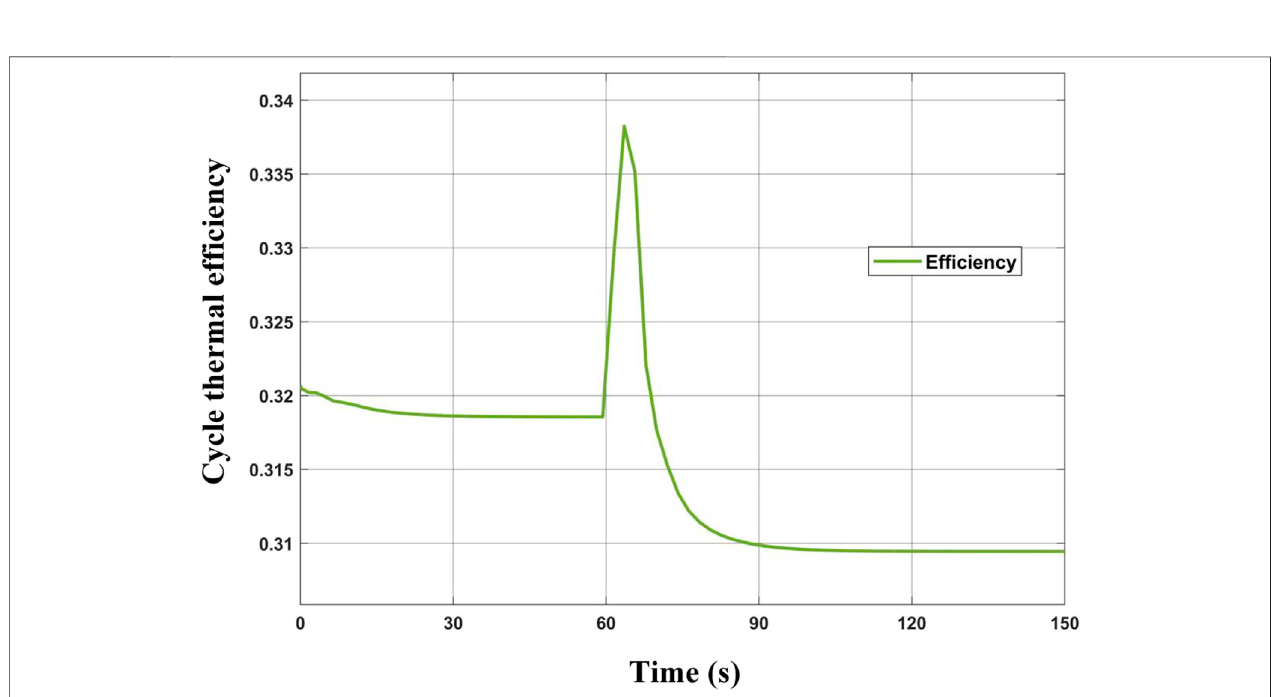
FIGURE 14 | Dynamic response of system thermal ef fi ciency while increasing the cycle mass fl ow